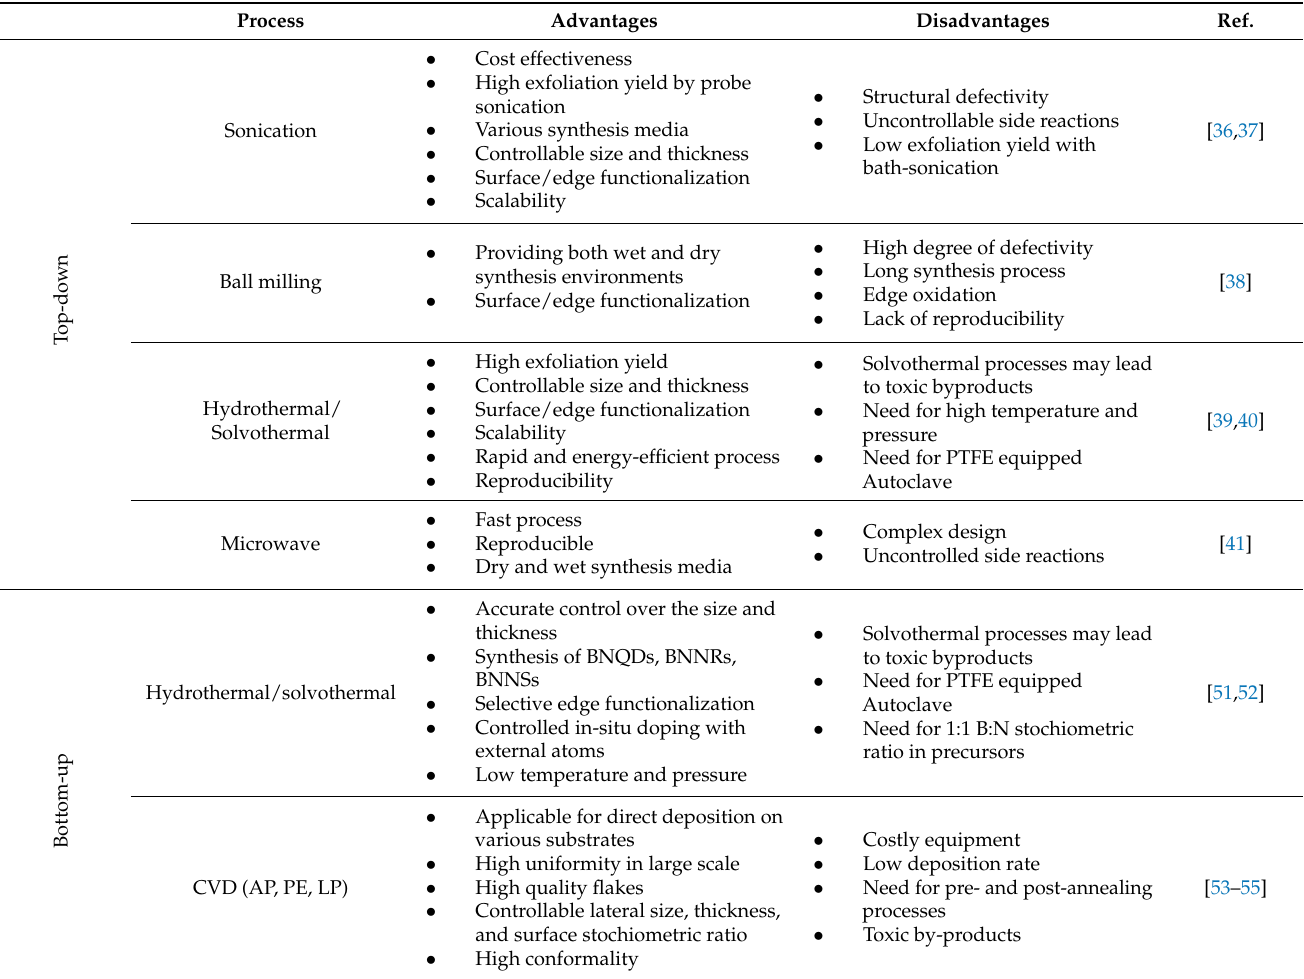
Table 1. Summary of advantages and drawbacks of 2D h-BN synthesis methods for application in energy